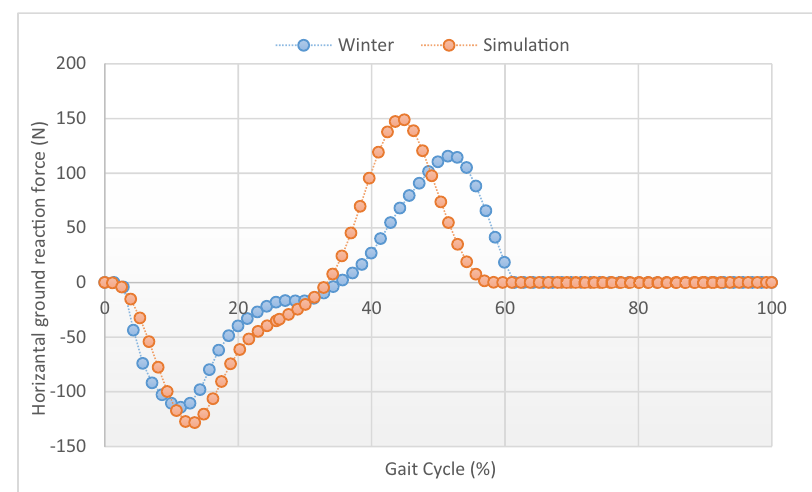
Figure 28: Comparison between model and healthy leg: HGRV vs gait